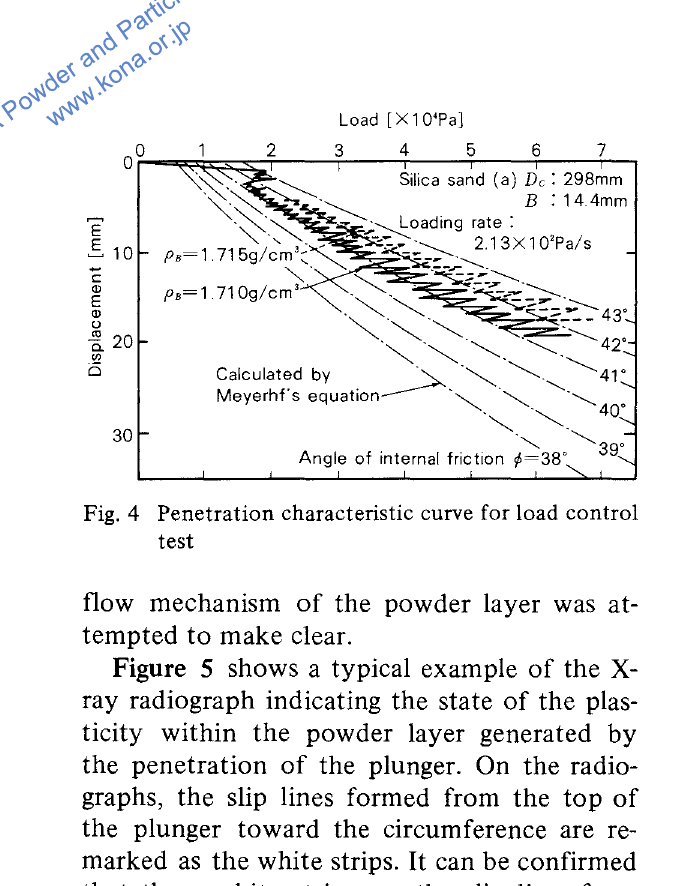
Fig. 4 Penetration characteristic curve for load control test